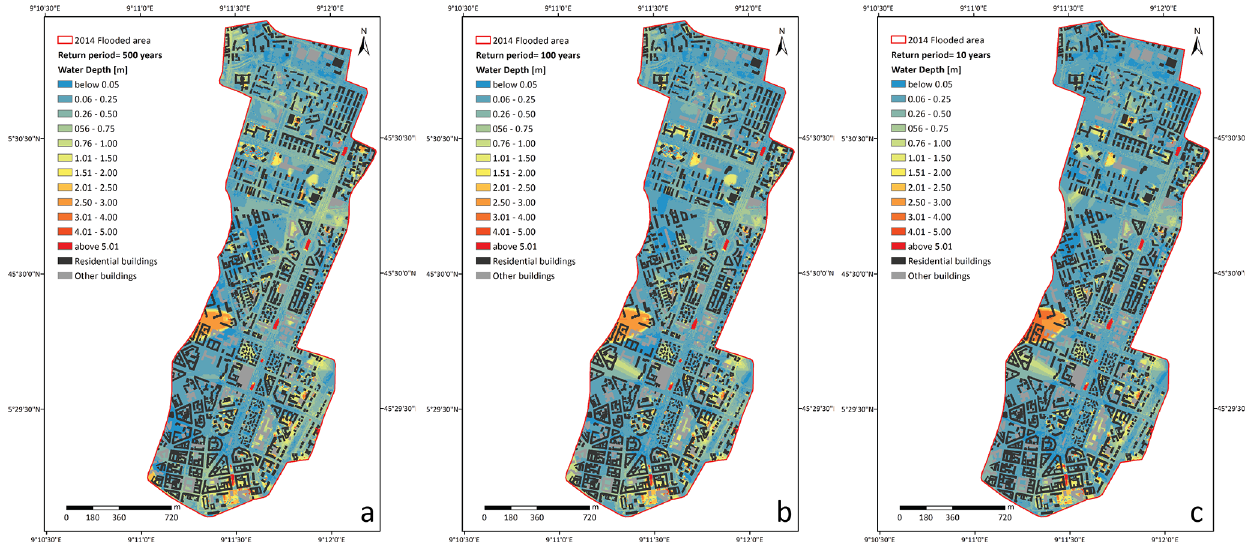
Figure 8. Estimated water depth and probability of flooding assuming return period scenarios of (a) 500, (b) 100 and (c) 10 years derived from 1-D and 2-D hydraulic modelling designed by the Municipality of Milan in 2019 for the Governmental Territorial Plan and the Flood Risk Management from © Regione Lombardia 2022. Built-up-area shapefile is from © OpenStreetMap contributors 2022. Distributed under the Open Data Commons Open Database License (ODbL)